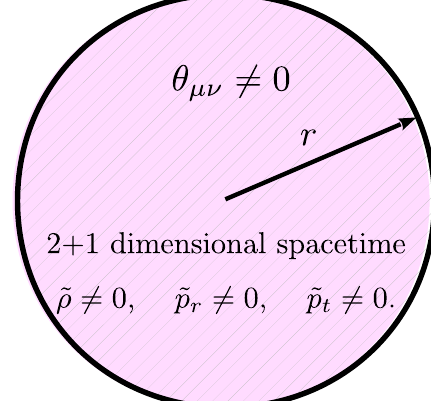
Fig. 1 Circularly symmetric space–time filled with both θ μν and cos- mological constant (cid:3) . Note that the case θ μν = 0 yields 2+1 dimen- sional black